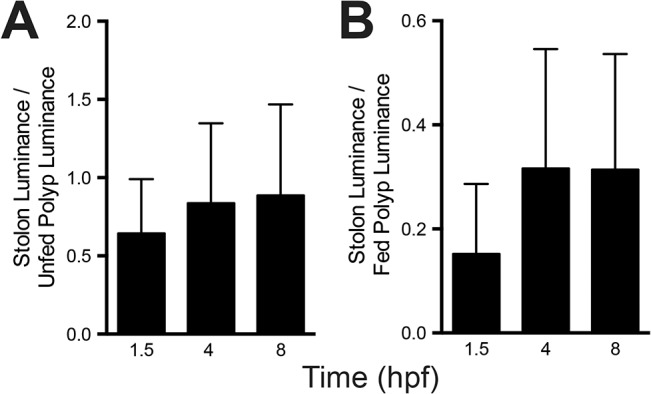
Luminance of hydrorhiza relative to polyps in late ontogeny.(A) Mean luminance of stolons standardized to the mean luminance of an adjacent unfed polyp (n = 34) at 1.5, 4 and 8 hpf. Errors bars show one standard deviation. (B) Mean luminance of stolons to mean luminance of the fed polyp at 1.5, 4 and 8 hpf (n = 34). Errors bars show one standard deviation.